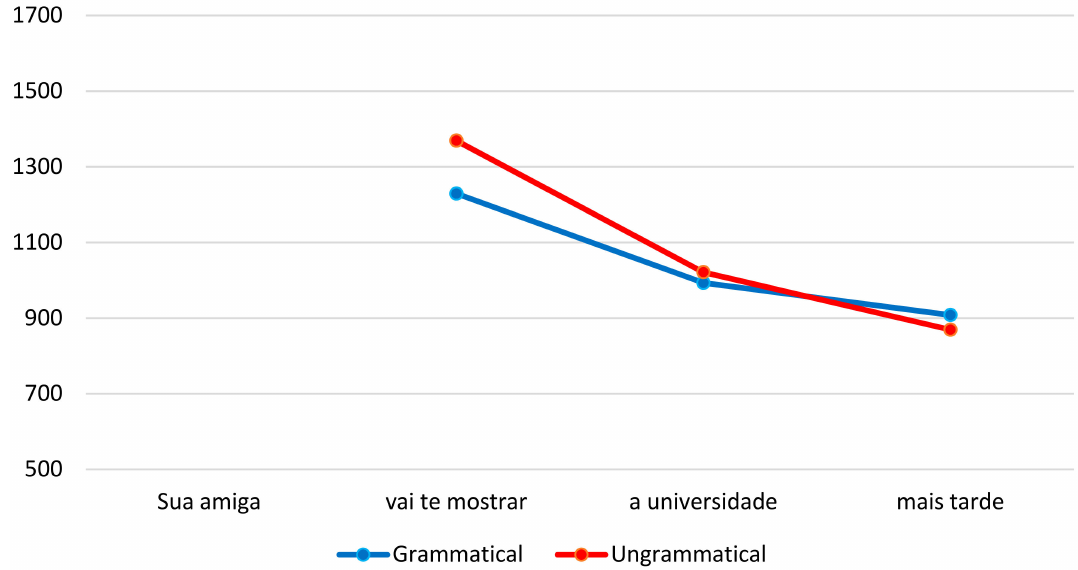
Figure 5. L1 Spanish speakers in the restructuring